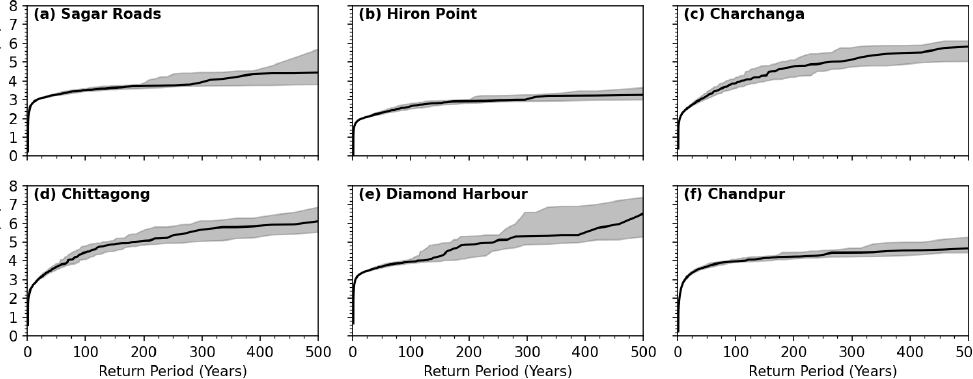
Figure 6. Extreme water level evolution with return period at (a) Sagar Roads, (b) Hiron Point, (c) Charchanga, (d) Chittagong, (e) Diamond Harbour, and (f) Chandpur. These station locations are shown in Fig. 5. The shaded grey area indicates the 95% confidence interval.